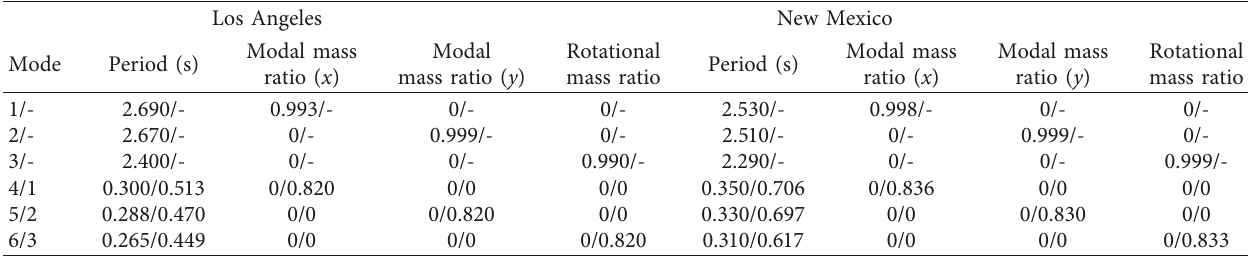
Table 17: Modal parameters of the hospital buildings under isolated/fixed-base conditions.